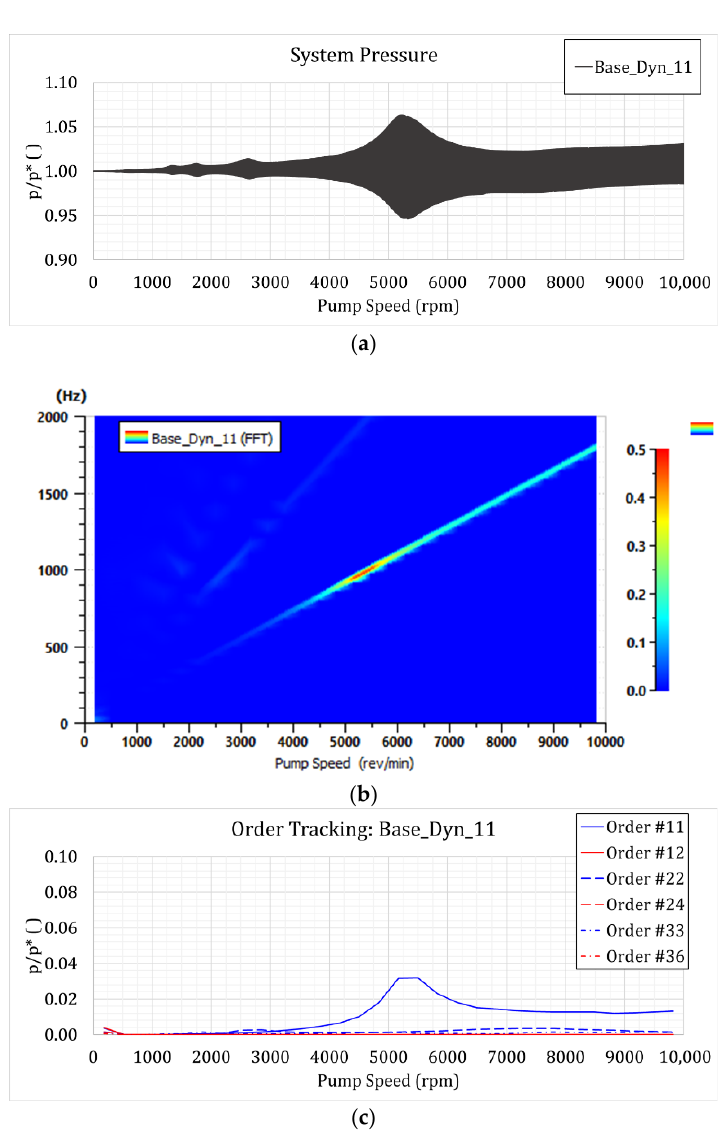
Figure 9. Results of Base_Dyn_11: ( a ) system pressure; ( b ) spectral map; ( c ) order tracking.